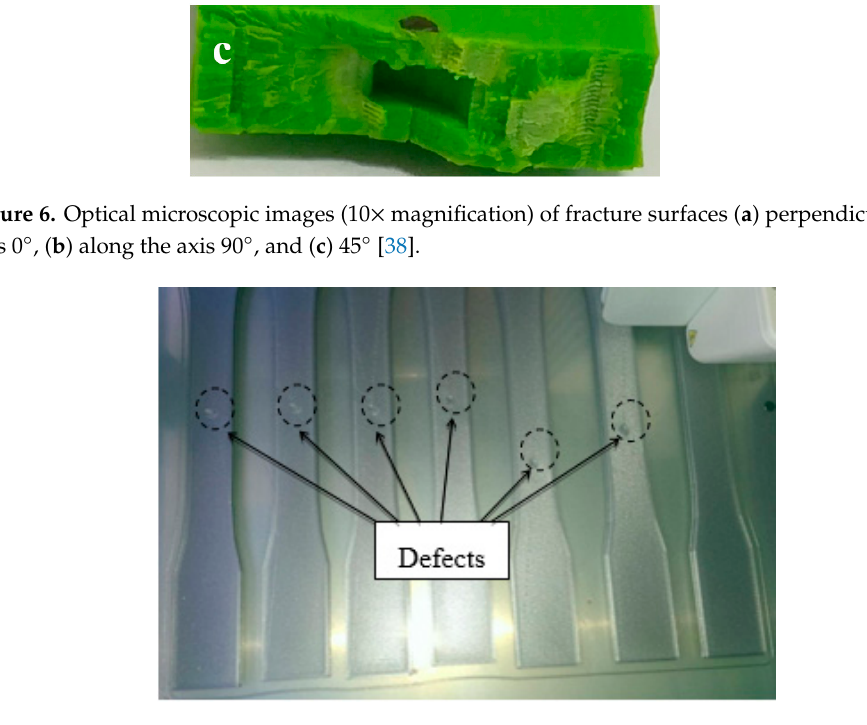
Figure 7. Internal defects captured during the three-dimensional (3D) printing of the grey specimens. Figure 8 shows the load-displacement curves of gray samples with different defect locations.